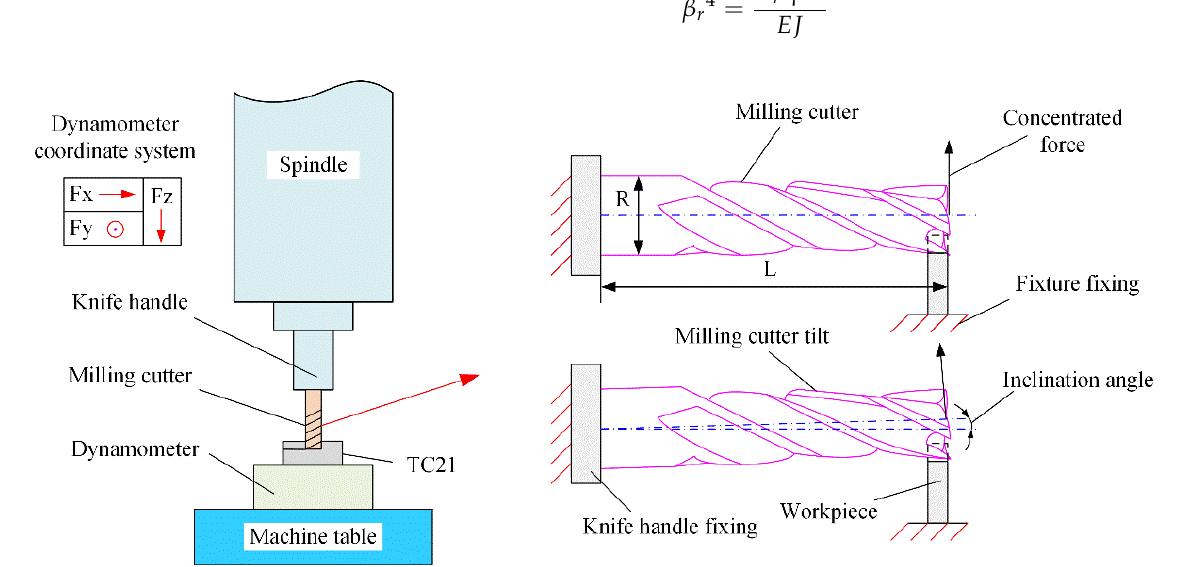
Figure 22. Force model of the milling cutter.